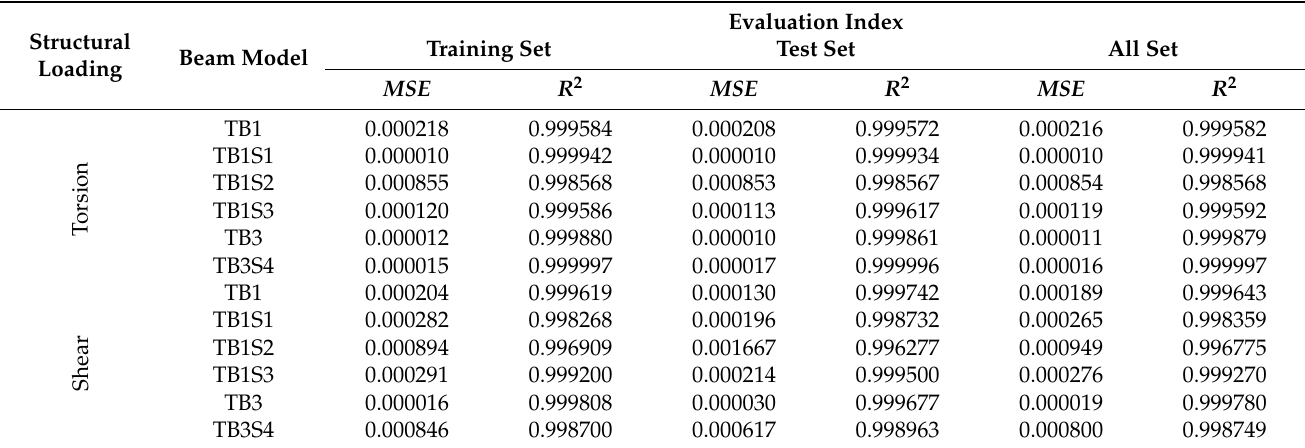
Table 8. Evaluation of the ANN model.